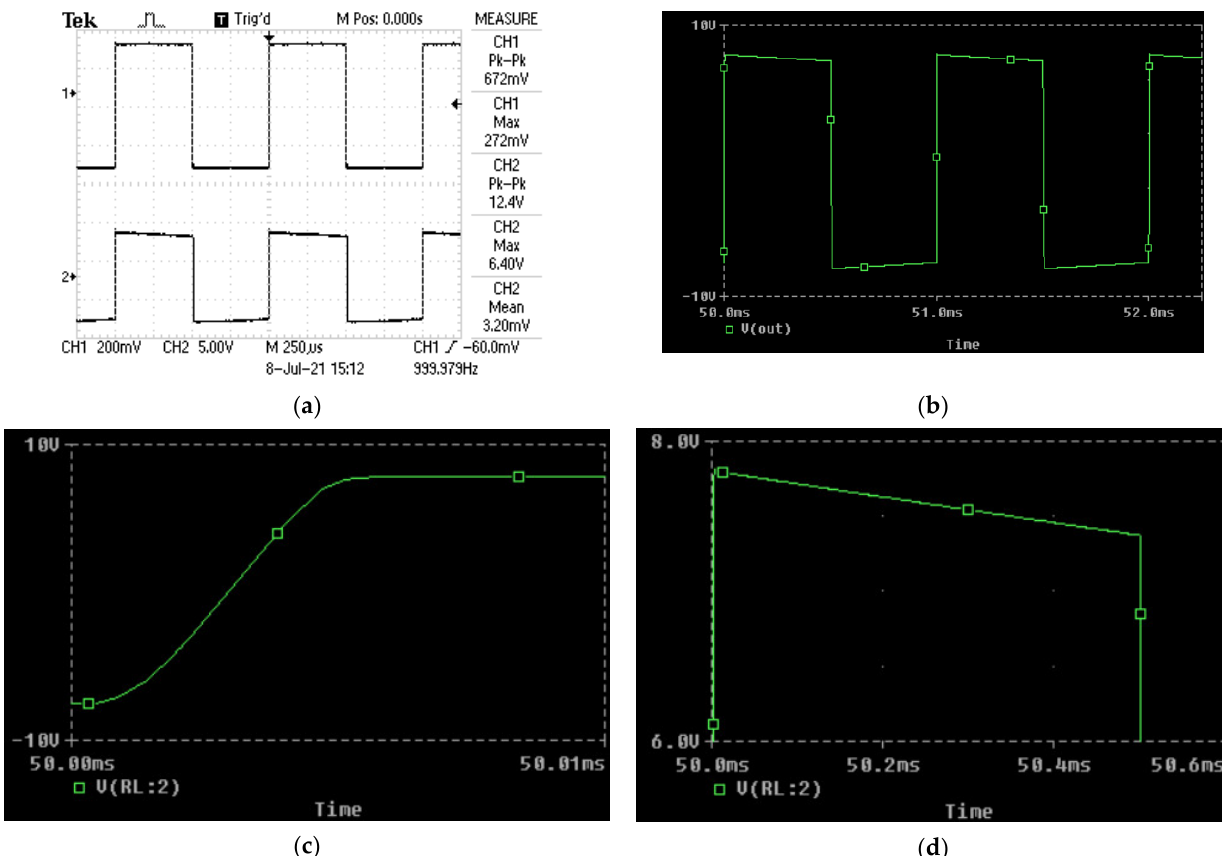
Figure 13. Large-signal transient response for the non-inverting amplifier in Figure 12: ( a ) measured results of the real device at a load resistance equal to 4 Ω; ( b ) simulated results of the proposed macro-model at a load resistance equal to 4 Ω; ( c ) simulated results for the positive slew rate of the macro-model at load 4 Ω; ( d ) simulated results for the voltage drop of the part of the output signal at 4 Ω